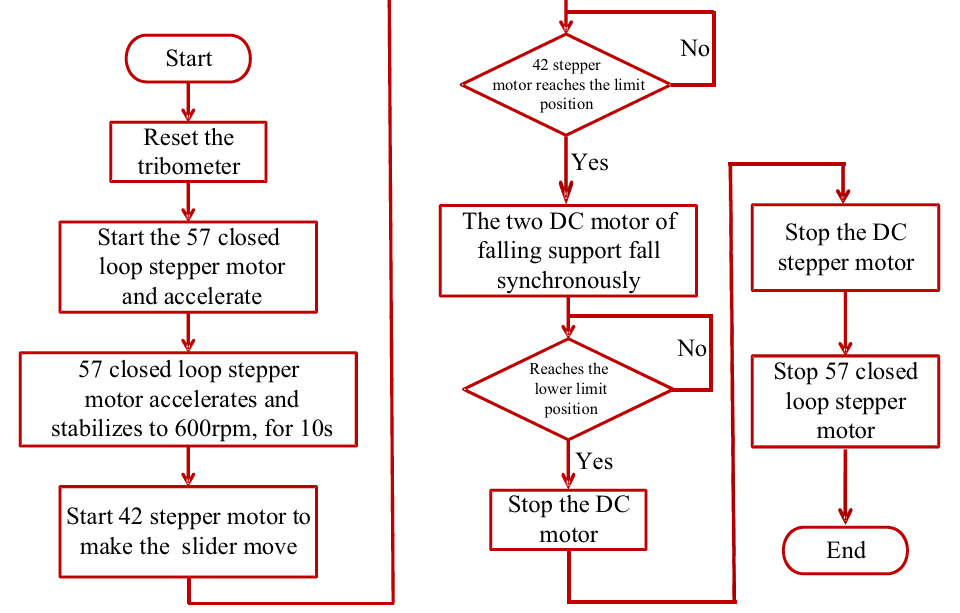
Figure 4. The flow chart of the control system.